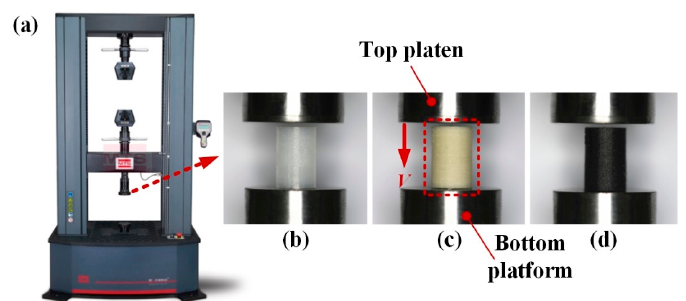
Figure 3. Quasi-static compression experiments and specimens printed by different materials: ( a ) universal material testing machine; ( b ) polyamide (PA); ( c ) short glass fiber-reinforced polyamide (PAGF); ( d ) short carbon fiber-reinforced polyamide (PACF).